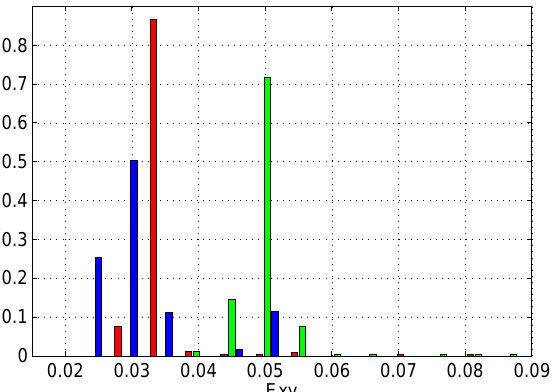
Figure 5. Histograms of E xy for two traditional PCC: Case A ( red ) and Case B ( green ) and for the proposed scheduled PCC ( blue